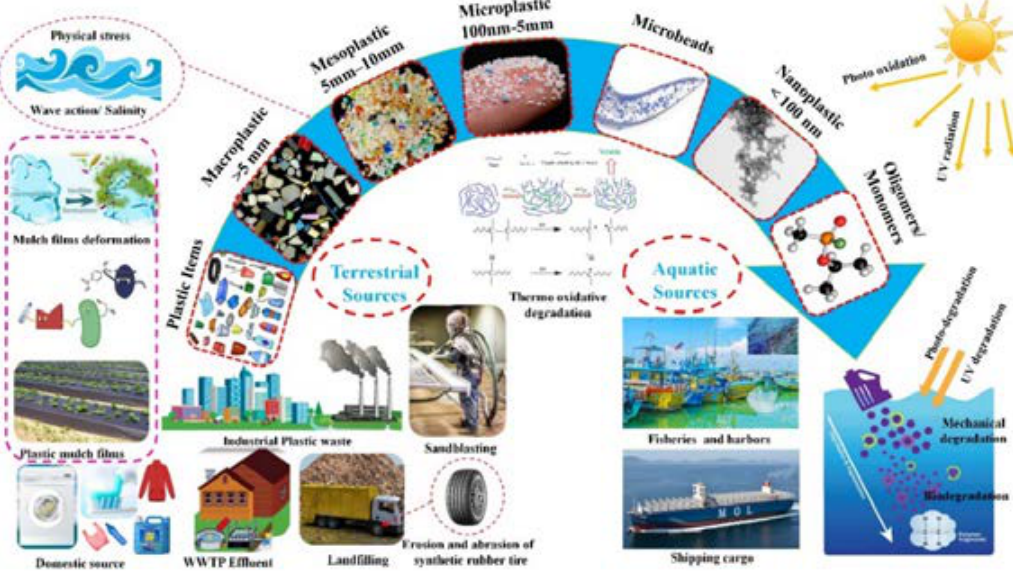
Fig. 1: Nano- and microplastic accumulation sources with the encircled (dotted lines) circle on the left showing the terrestrial sources and that on the right showing the aquatic sources. The range in the size of plastic debris resulting from the degradation and fragmentation pro - cess of plastic items to oligomers/monomers is shown across the arc in blue. Each of the squares represented in the red dotted line shows the standard size range as a result of different fragmentation